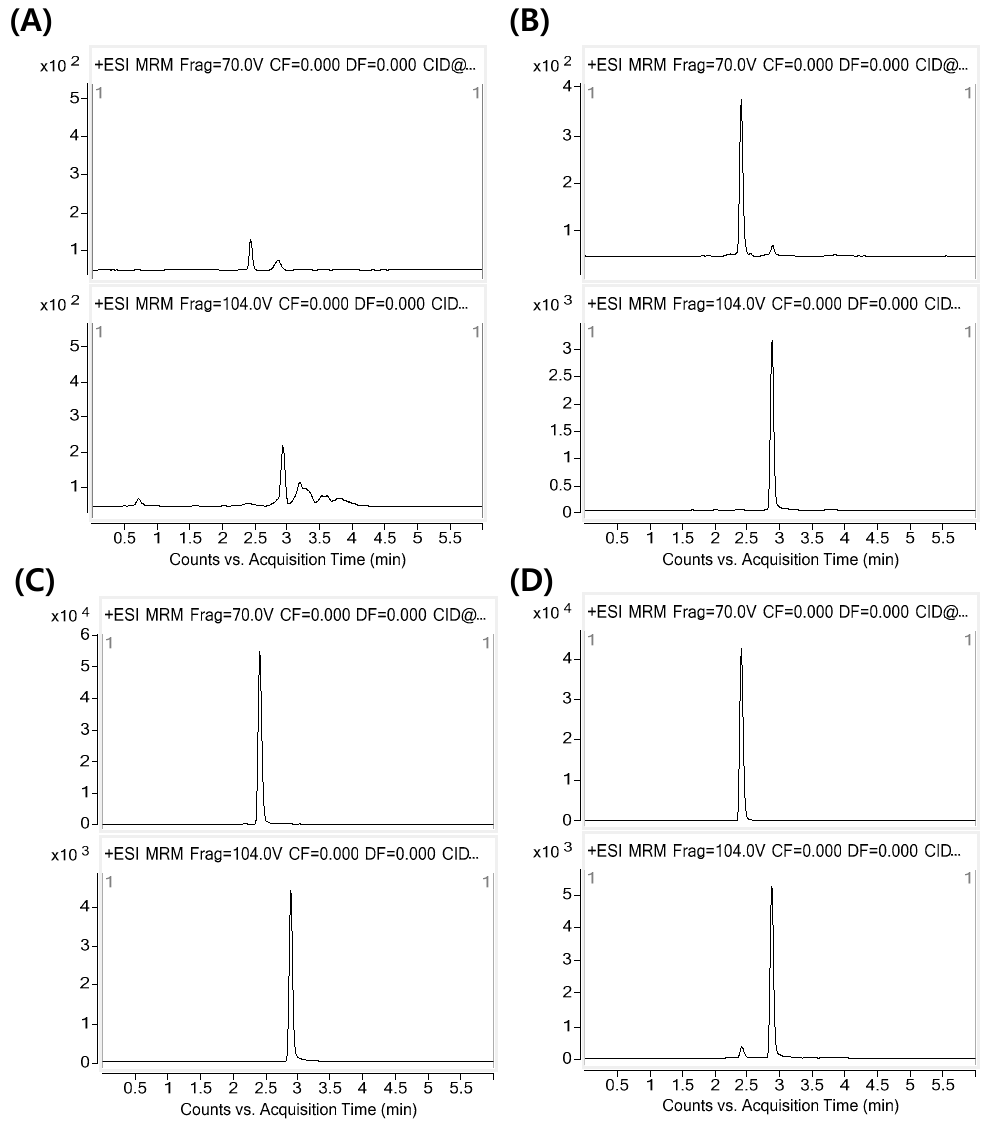
Figure 2. Typical MRM chromatograms of ATEC (top) and TBC (IS; bottom), ( A ) blank rat plasma, ( B ) blank rat plasma spiked with ATEC (10 ng / mL) and IS (100 ng / mL); rat plasma samples taken ( C ) 2 min after i.v. and ( D ) 15 min after p.o. administration of ATEC .